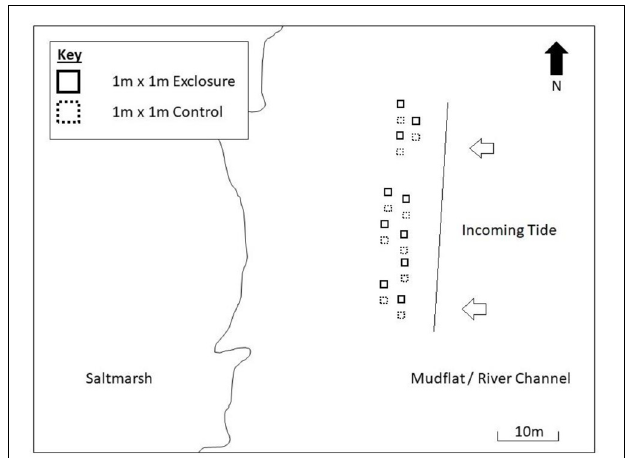
FIGURE 1 | Experimental layout adjacent to Geedon Saltings, Essex Wildlife Trust Fingringhoe Wick, Essex (grid reference TM 05065 19030).